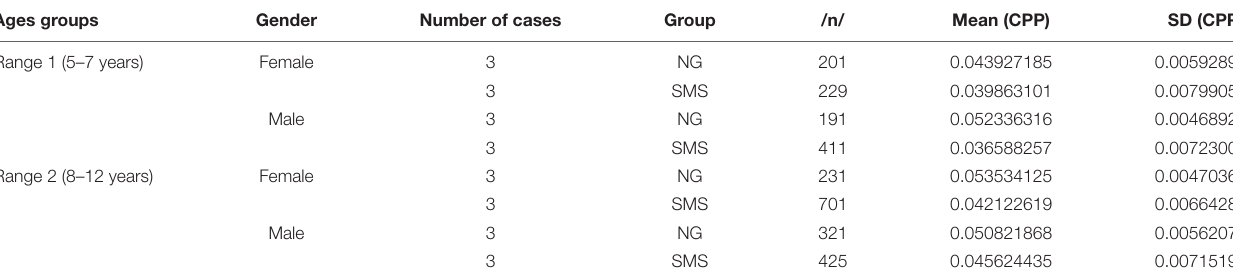
TABLE 2 | Summary of statistical values for cepstral peak prominence